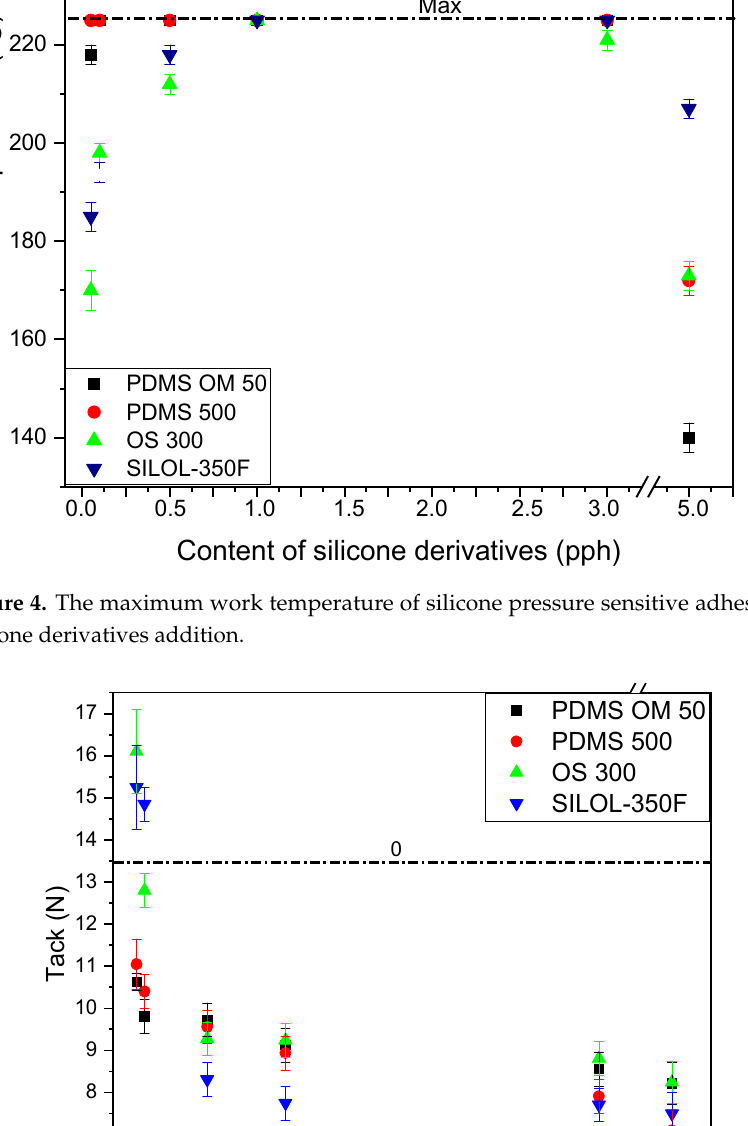
Figure 5. Effect of silicone derivatives addition on the tack of silicone pressure sensitive adhesives.